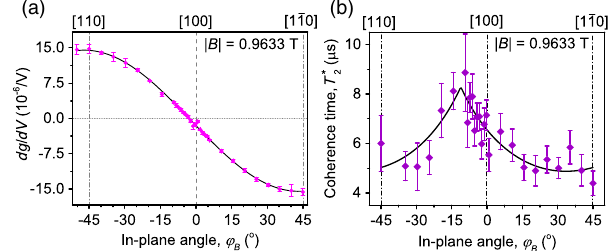
FIG. 3. The derivative of the Stark shift and T (cid:1) 2 measurement. (a) Stark shift and (b) decoherence time T (cid:1) 2 of the qubit defined by the G1 quantum dot in the (3,0) charge configuration as a function of the external magnetic field in-plane angle φ